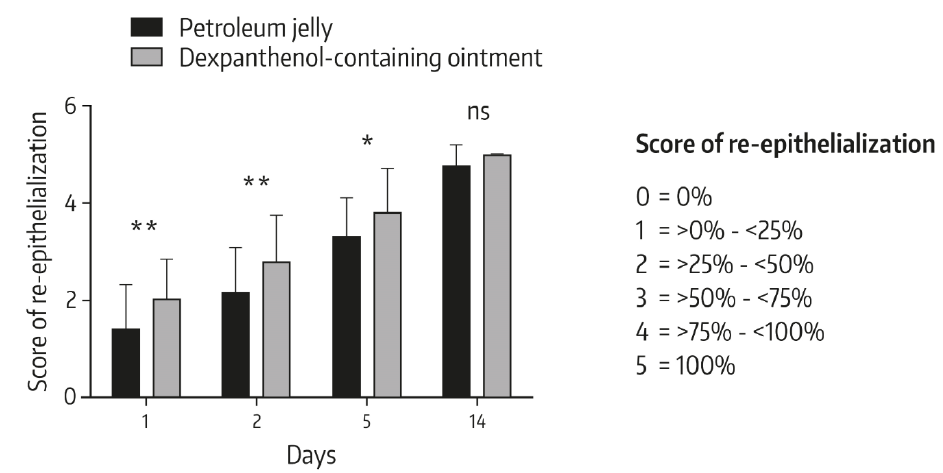
Figure 3. Visual changes of the wound healing between study visits. The wound healing rates were visually assessed, based on the measure of re-epithelialization. Data show mean ± standard deviation with n = 38, * p < 0.05, ** p < 0.01 (Mann – Whitney U test); ns: not significant. From Ref. [2] reprinted with permission of Informa UK Limited, trading as Taylor & Francis Group (www.tandfonline.com).